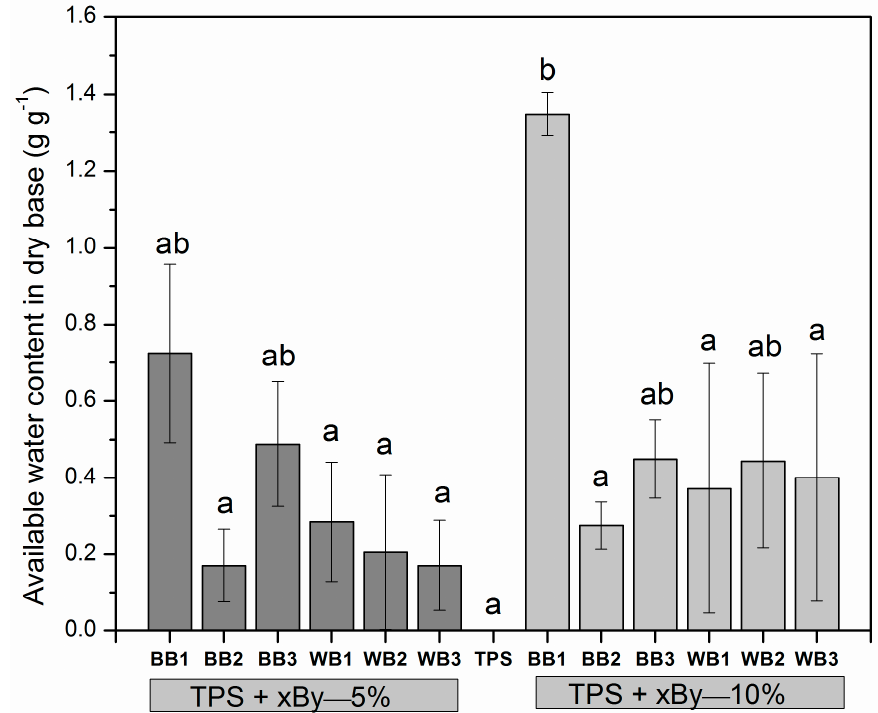
Figure 5. Available water content at mixtures of TPS and twelve biochars made of bamboo and pinewood applying two doses (5% and 10% dry wt). Different letters show statistically significant differences between variables using Tukey’s test ( p < 0.05). Notice that the corresponding biochars in the mixture were denoted as x B y , being x the feedstock source (B or W) and y the lot number (1, 2 or 3).